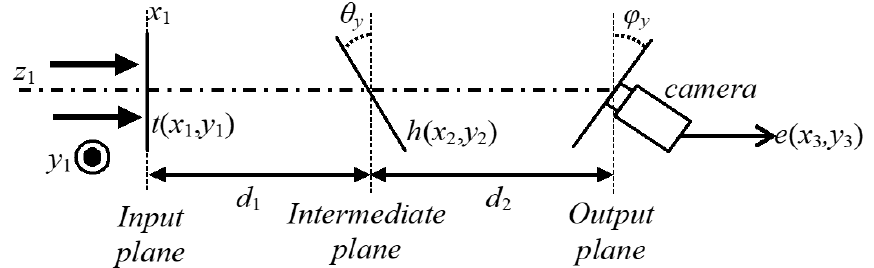
Figure 2. Optical scheme of the encryption system using the DRPE technique and the optical diffraction on two tilted